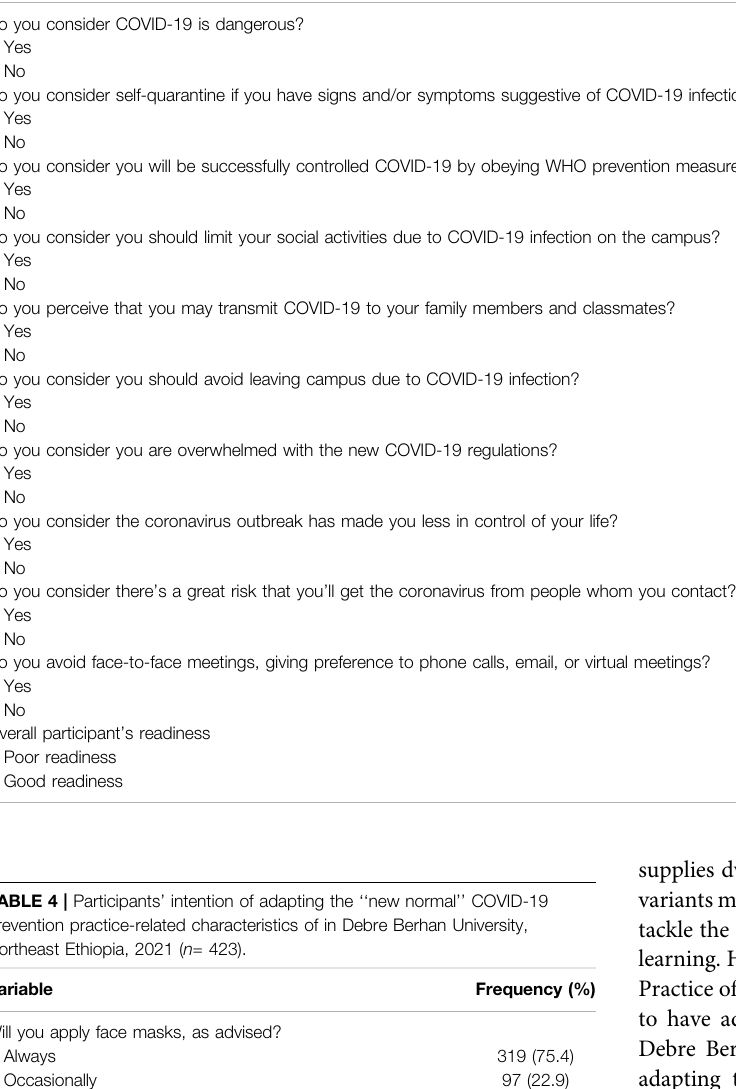
TABLE 3 | Participants ’ readiness-related characteristics about COVID-19 prevention campaign in Debre Berhan University, Northeast Ethiopia, 2021 ( n (cid:1) 423). Questions